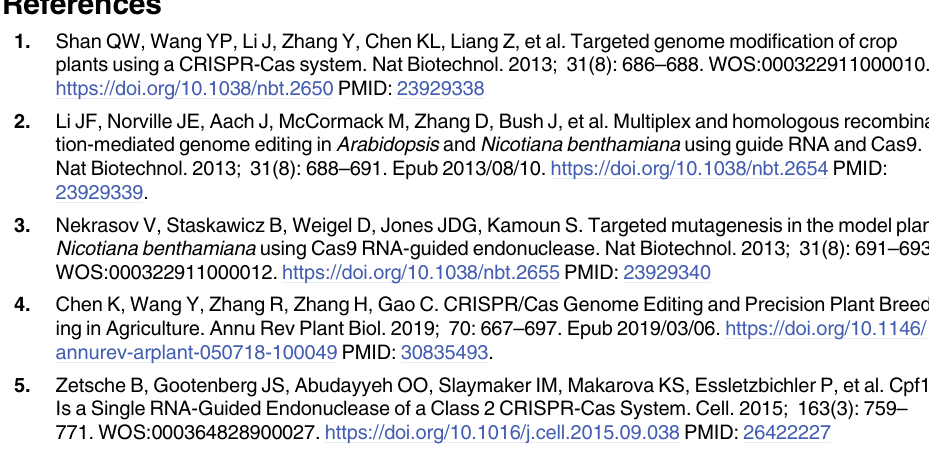
S1 Table. Editing efficiencies of different promoters. S2 Table. Primers used in this